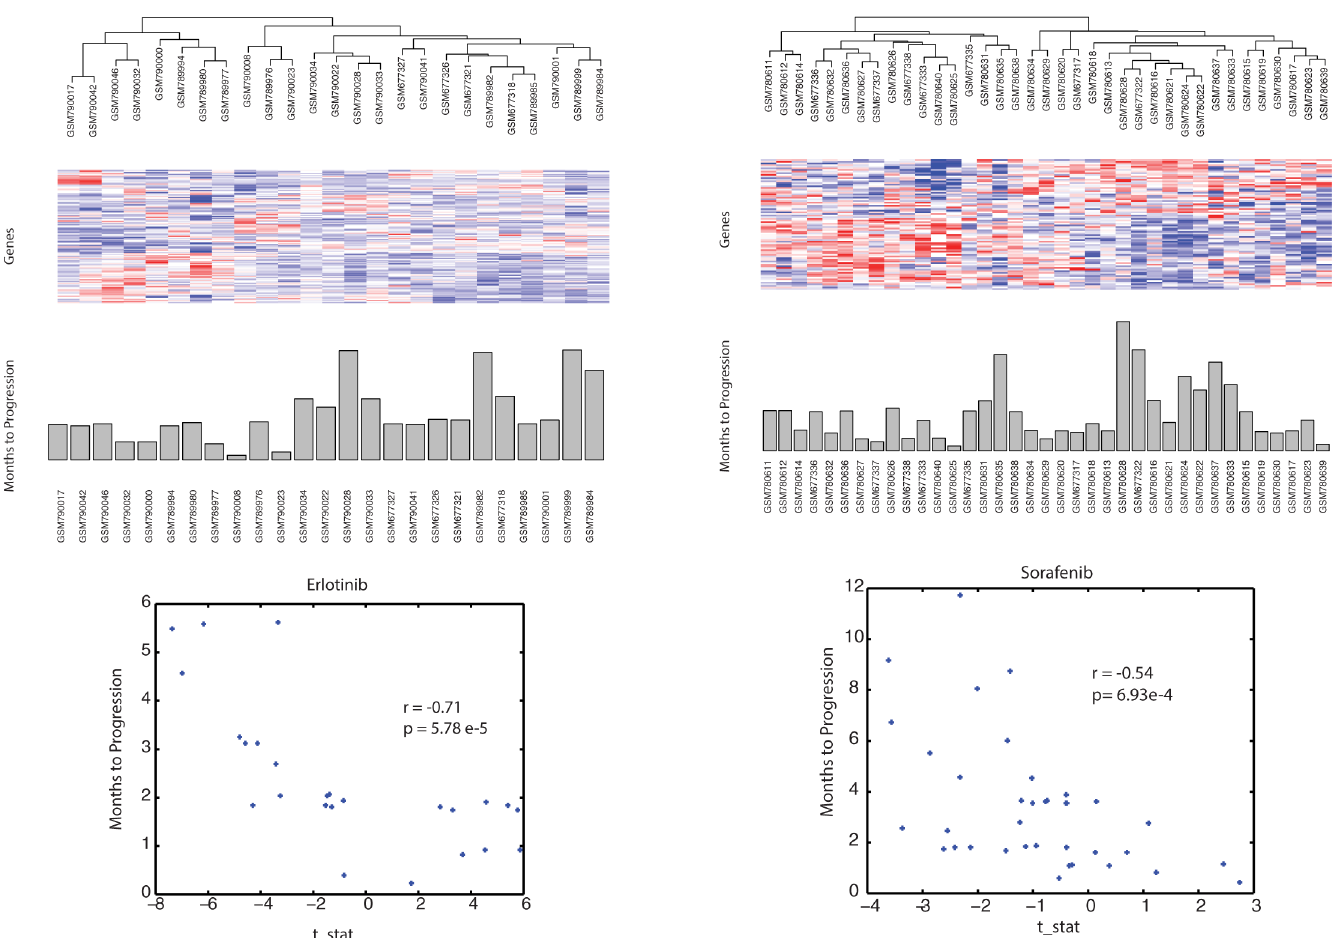
Fig 12. Results for selecting n = 127(erlotinib; left half) and n = 81(sorafenib; right half) patient-derived gene expressions using pathway scores. Top panel for each drug displaysthe dendrogram from the clustered organization (correlationdistancemetric, Wards linkage)of gene expressions (second panel). Third panel displaysthe Months to Progression for patients organized accordingto the dendrogram in the top panel.Fourth panel displaythe correlationof the t_stat from a t-test comparing the gene expressions from pathwayswith large positive H scores to gene expressions from pathways with large negativeH scores to Months to